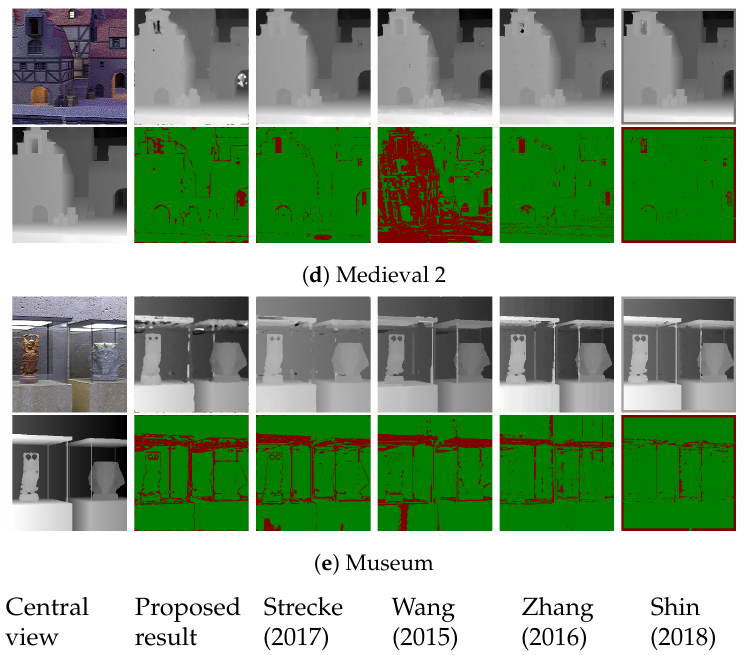
Figure 19. Visual comparison of the proposed algorithm with Strecke et al. [9], Wang et al. [10], Zhang et al. [11] and Shin et al. [12] for synthetic LF images.